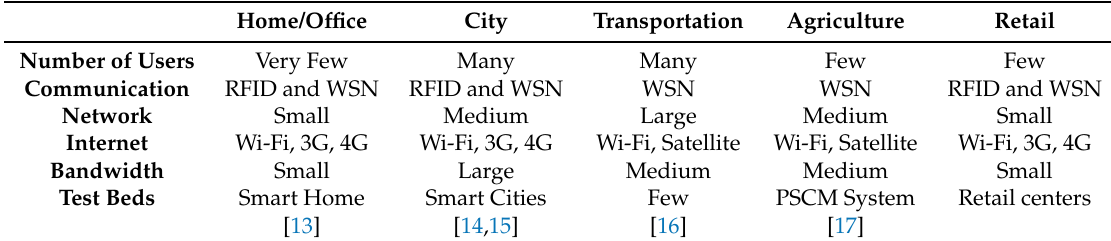
Table 1. Comparison of different application domains of IoT.